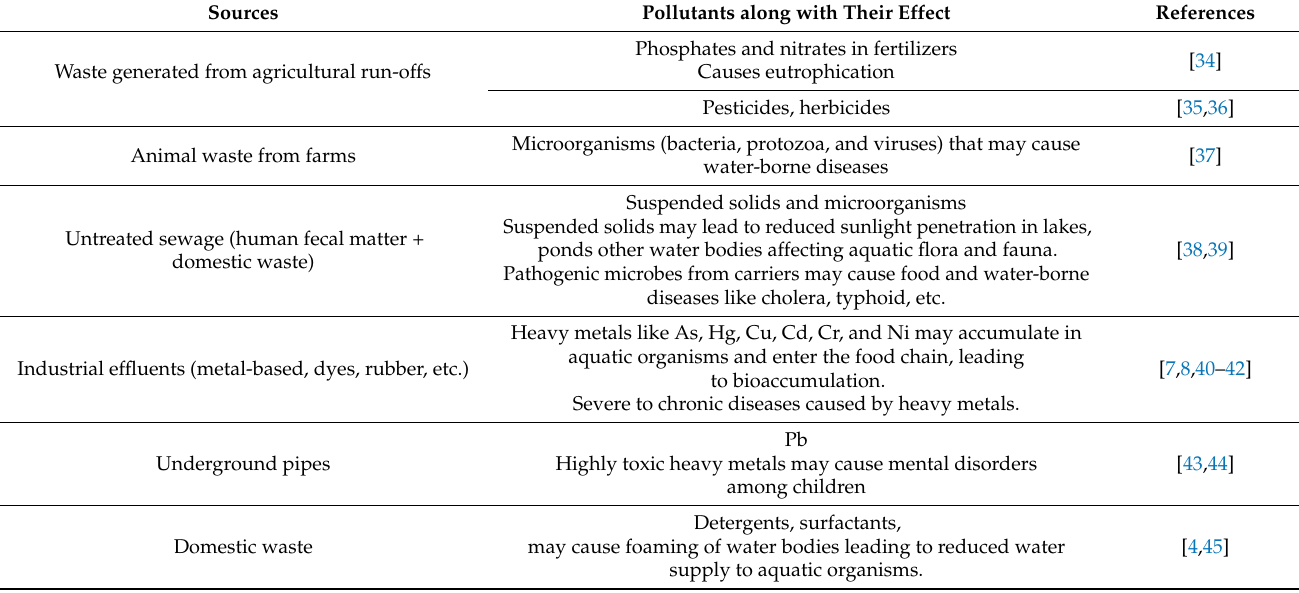
Table 1. Sources of water pollution along with their side effects.